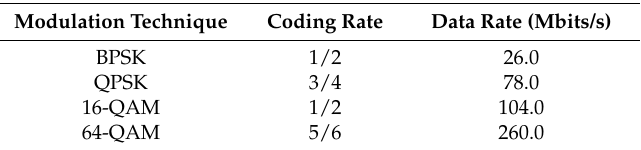
Table 1. List of bands and channels.